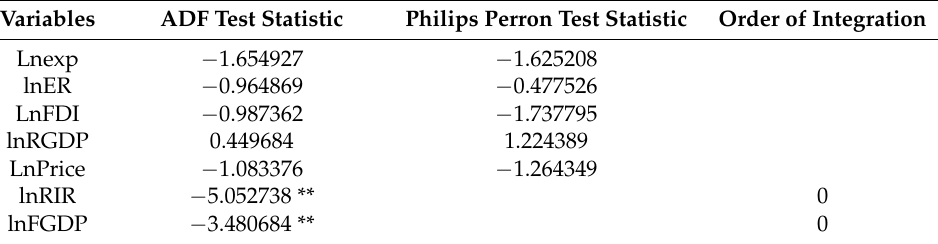
Table 2. Unit root tests at the levels of the variables.